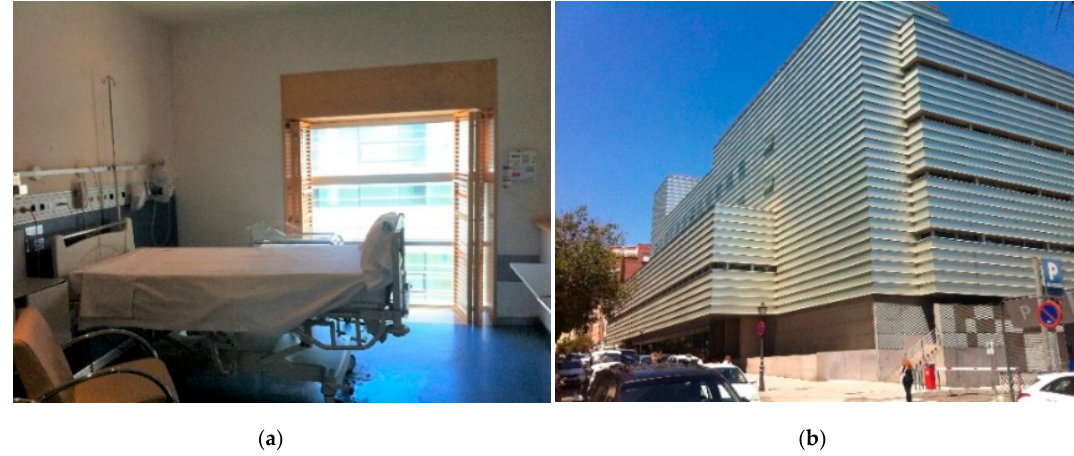
Figure 2. Interior and exterior photos for the case study. ( a ) Typology of patient rooms; ( b ) hospital building for the study.